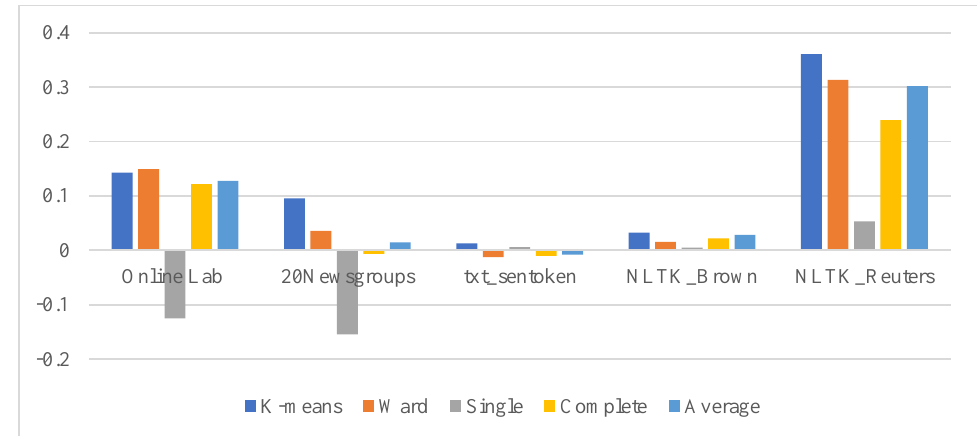
Figure 10. Similarity ratio preprocessing with stemming (PPWS).